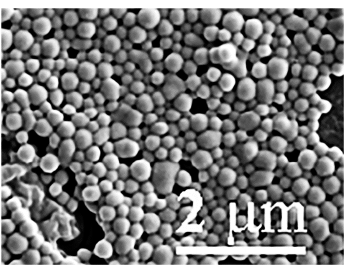
Figure 3. Size of lactomicroselenium particles measured by scanning electron microscopy after isolation and purification.